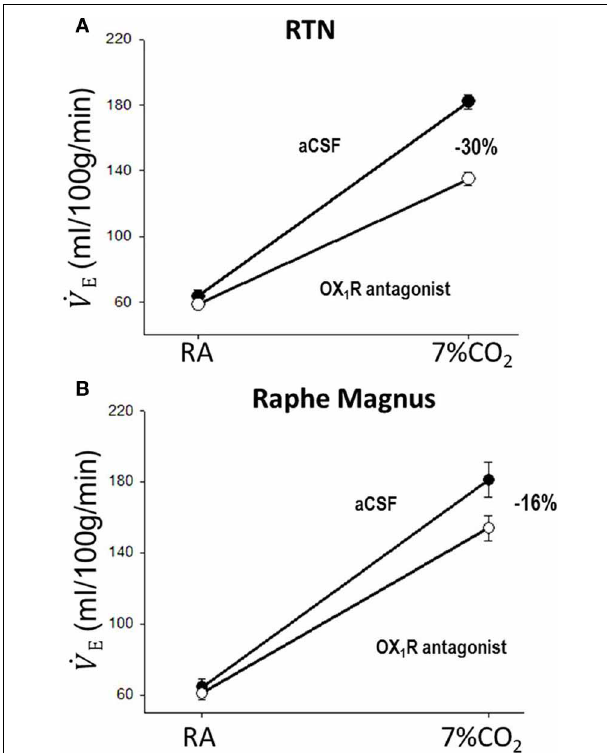
FIGURE 11 | Systemic antagonism of OXRs decreases the CO 2 chemoreflex. Antagonism of both OX 1 R and OX 2 R by orally administrating a dual OXR antagonist, Almxt, significantly decreased the hypercapnic chemoreflex only in wakefulness during the dark period of diurnal cycle ( − 26%). In the dark period, there was a significant difference between the ventilation breathing 7% CO 2 in control compared to Almxt treatment in the awake state ( ∗ P < 0.05). (Figure used with permission from Li and Nattie,